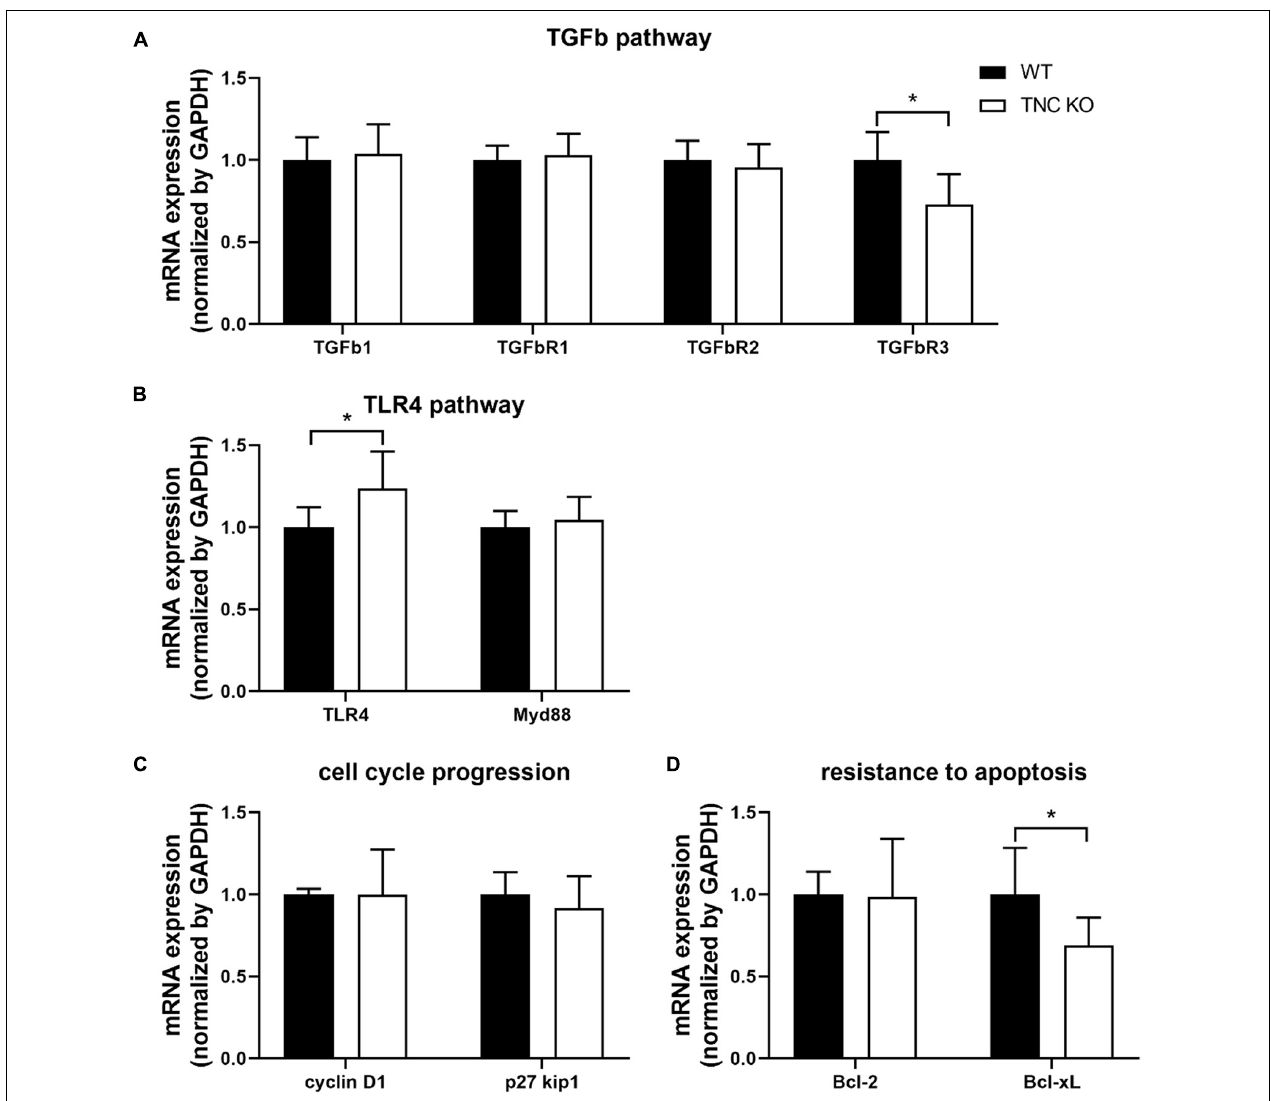
FIGURE 8 | TNC-related molecular pathways in old TNC-deficient and WT lungs. (A) : mRNA expression of TGF β pathway intermediates evaluated by RT-qPCR from whole lung lobe total RNA extractions of old TNC-deficient ( (cid:3) ) and WT ( (cid:4) ) animals. N = 6 animals/genotype. (B) : mRNA expression of TLR4 pathway intermediates evaluated by RT-qPCR from whole lung lobe total RNA extraction of old TNC-deficient ( (cid:3) ) and WT ( (cid:4) ) animals. N = 6 animals/genotype. (C,D) : mRNA expression of cell cycle proliferation and resistance to apoptosis pathways intermediates, through interaction with integrins, evaluated by RT-qPCR from whole lung lobe total RNA extraction of old TNC-deficient ( (cid:3) ) and WT ( (cid:4) ) animals. N = 6 animals/genotype. Results are expressed as mean ± SD. Statistical analyses were made by Student’s t test. Statistical significance was set at p < 0.05; * p <